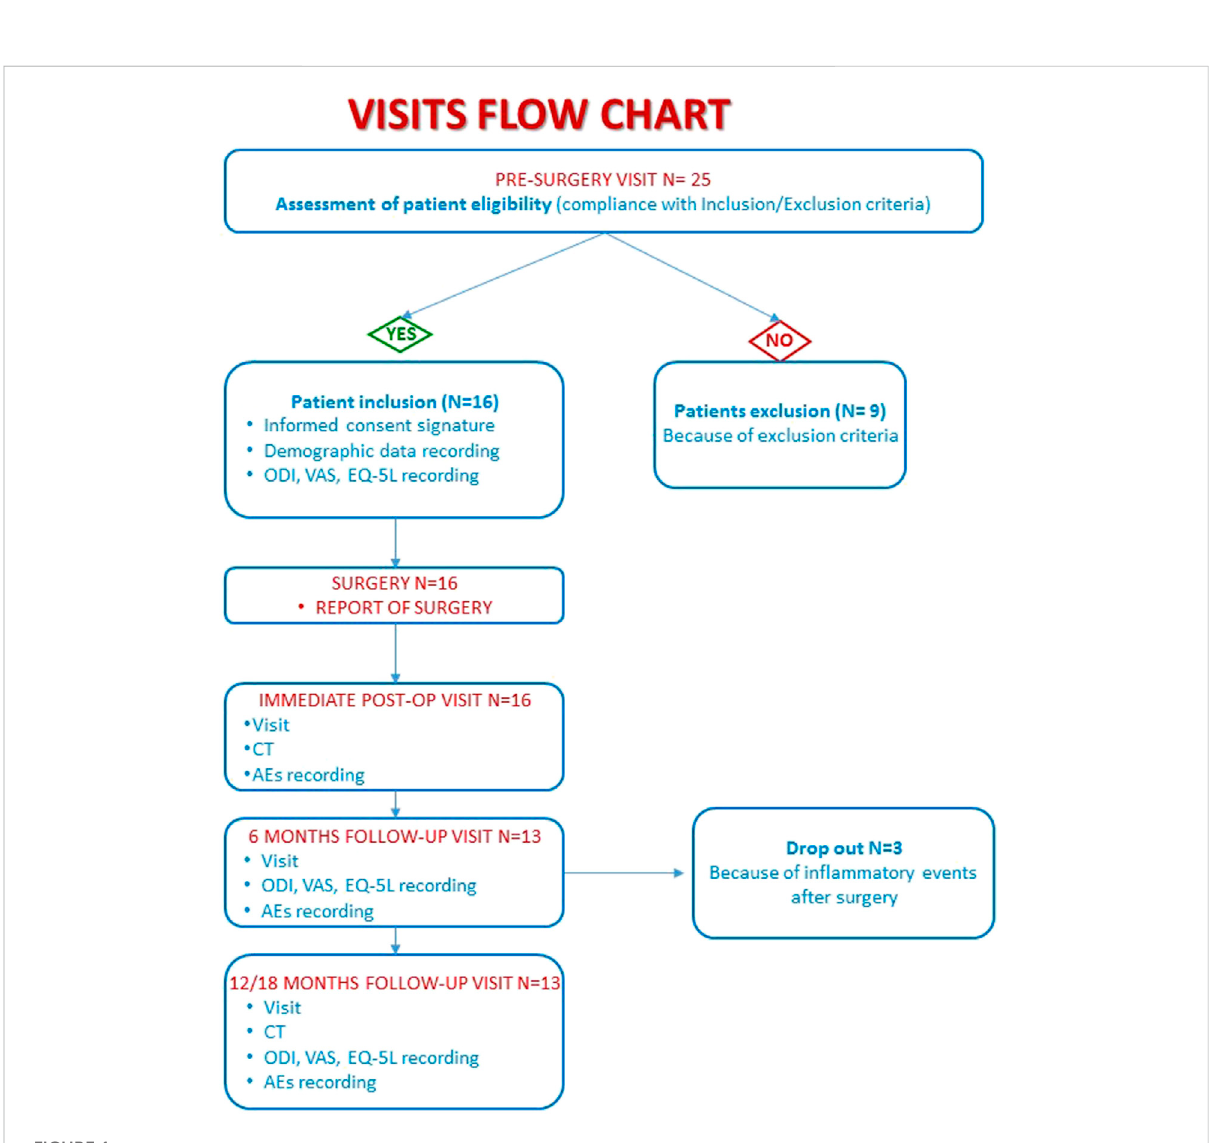
FIGURE 1 Flow chart of pre-operative and post-operative